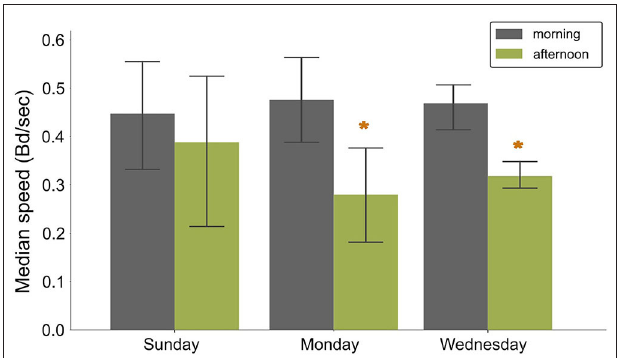
FIGURE 7 | Bar plots showing the variation of the normalized speed (bd/frame) for different feeding and husbandry scenarios in RAS. Bars indicate mean values and whiskers the standard deviation. Sunday = fasting, Monday = feeding after fasting, Wednesday = normal feeding day. Asterisks show statistically significant